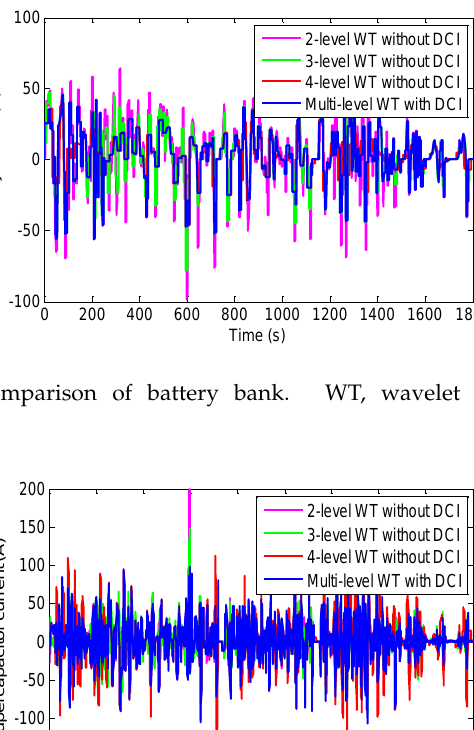
Figure 25. Voltage comparison of battery bank. WT, wavelet transform; DCI, driving cycle